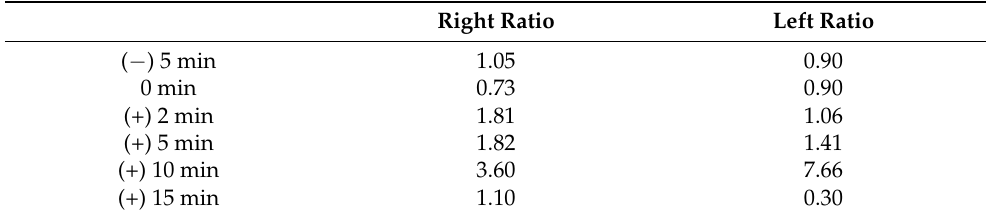
Table 2. Right and left petrosal sinus to peripheral serum ACTH